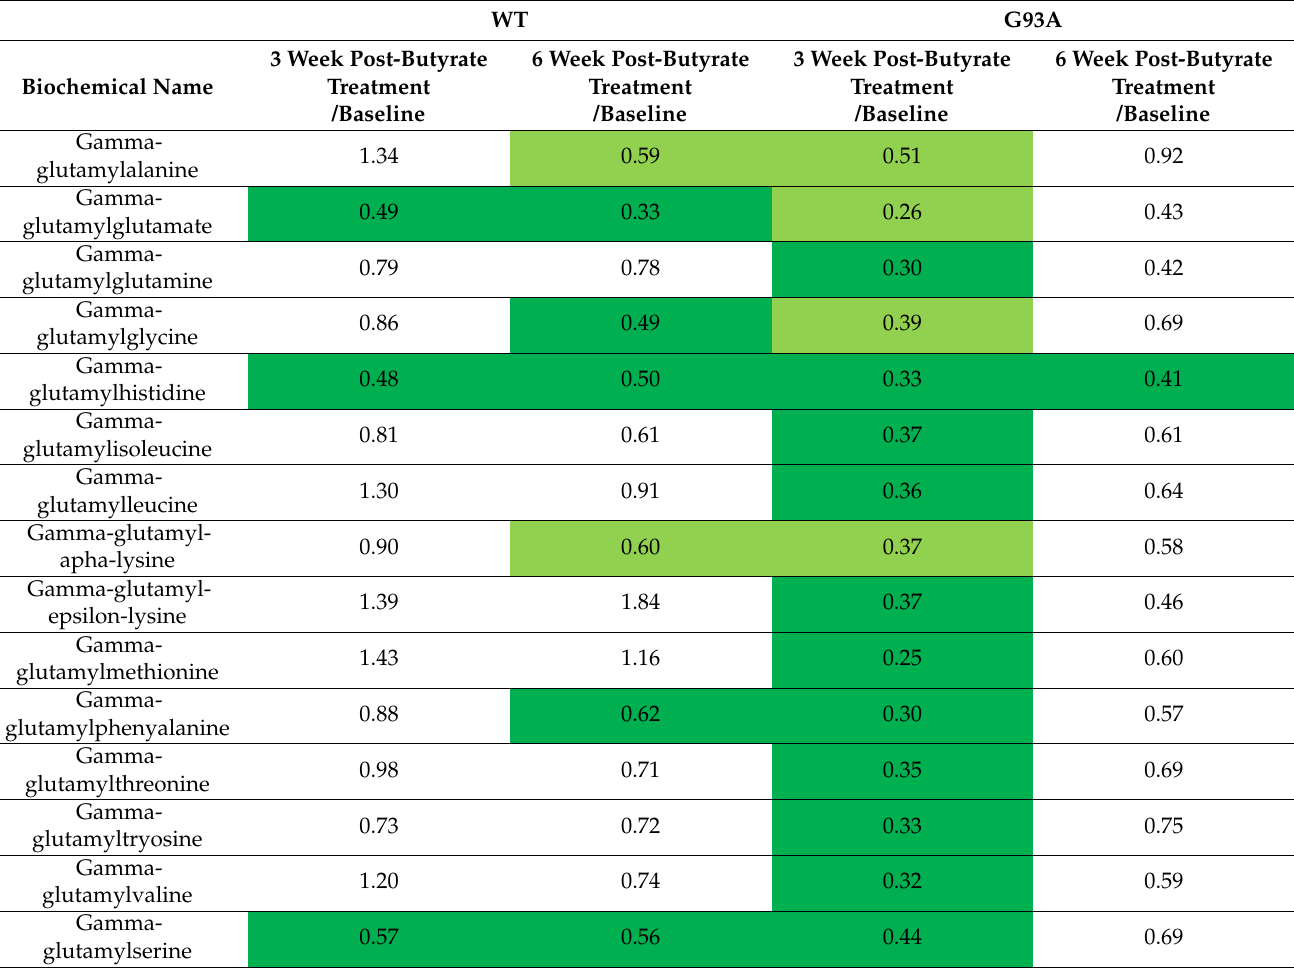
Table 3. Butyrate treatment causes shifts in the gamma glutamyl amino acid profile in ALS compared to WT mice. WT